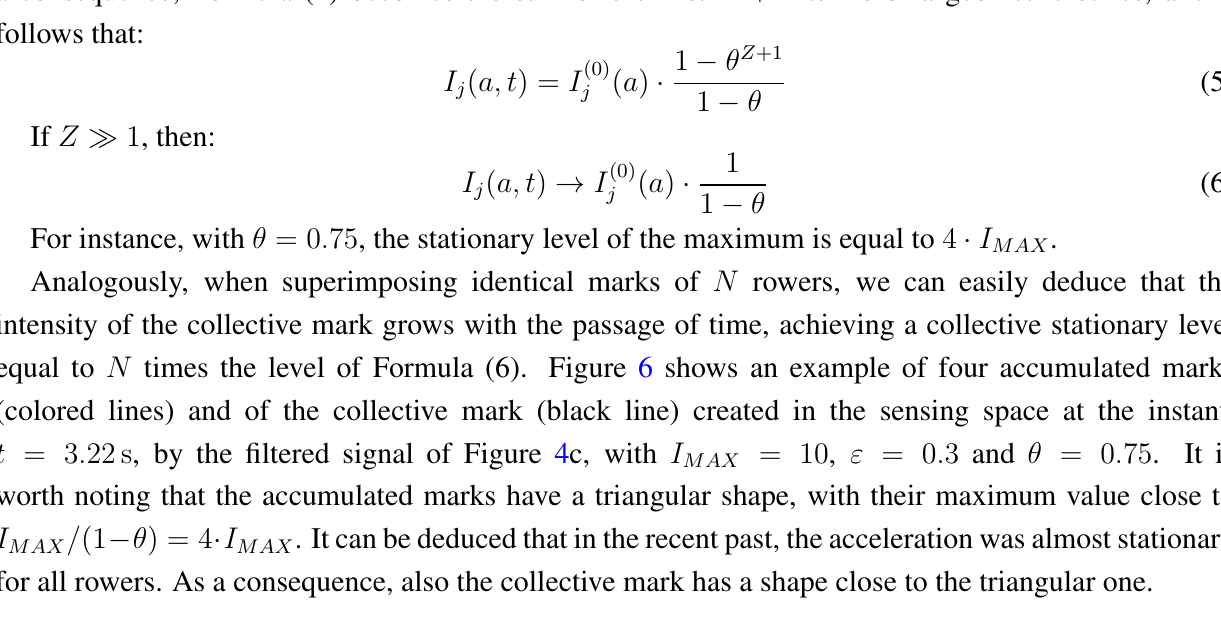
Figure 6. An example of four accumulated marks (colored lines) and of a collective mark (black line) created in the sensing space at the instant t = 3.22 s by the signal of Figure 4 = 10 , ε = 0 . 3 and θ = 0 . 75 (c) (pilot scenario), with I MAX